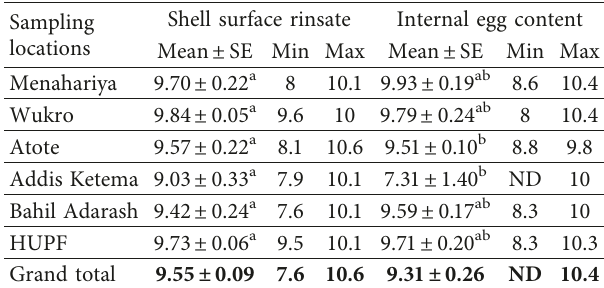
Table 2: Aerobic mesophilic bacterial count (AMBC) in log ml of the shell surface rinsates and contents of egg samples in Hawassa City, southern Ethiopia, 2019.